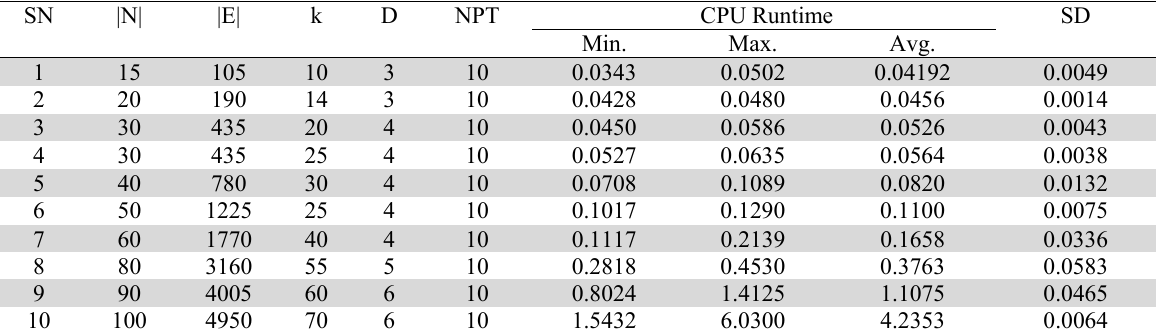
Mean results of the LSA for k-MSTPD over random